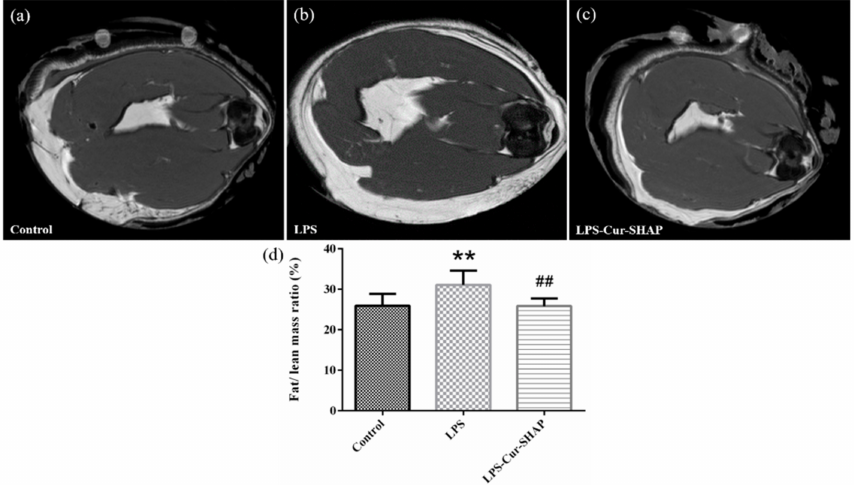
Figure 10. MRI images of the cross-section of the muscle in the ( a ) control group, ( b ) LPS group, and ( c ) LPS-Cur-SHAP group. ( d ) The ratio of fat and lean mass was calculated using image J ( n = 6, ** p < 0.01 compared to the control; ## p < 0.01 compared to the LPS group). The ratios of fat mass to lean mass in the muscles of the control, LPS, and LPS-Cur-SHAP groups were 25%, 31%, and 25%, respectively.